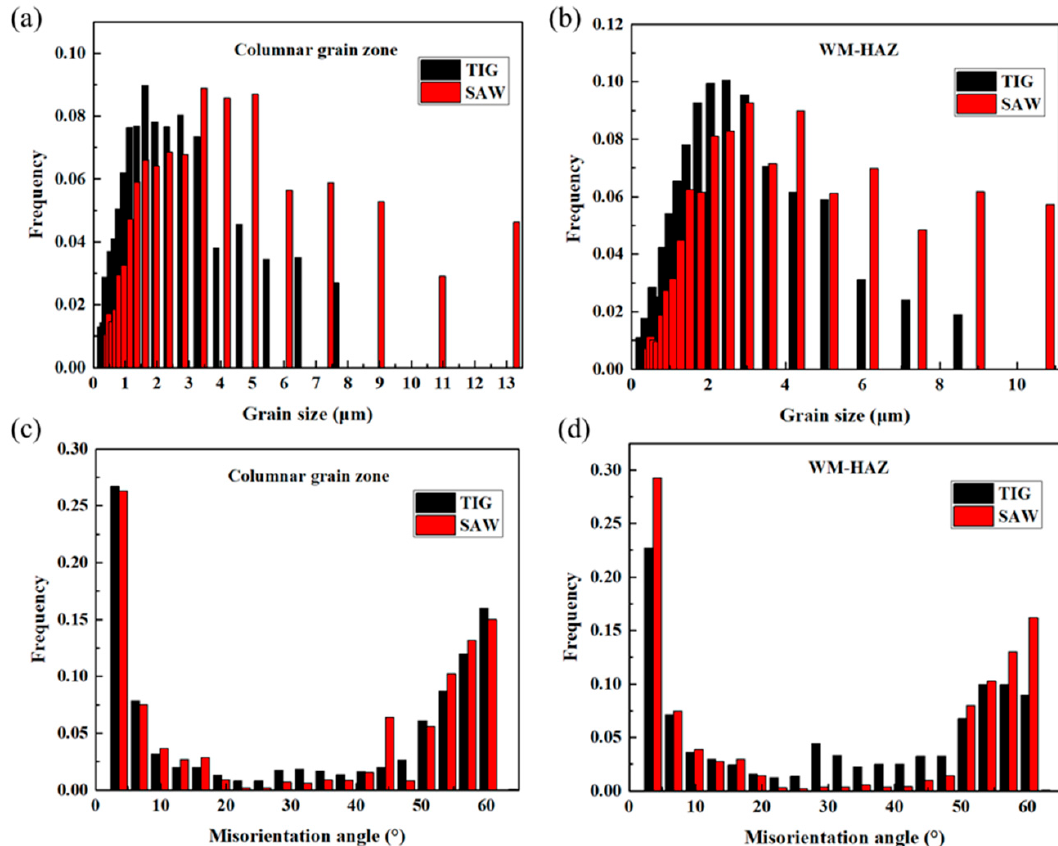
Figure 7. The distributions of grain size and number fraction of misorientation angles in columnar grain and reheated zones of weld metal. ( a ) The distribution of grain size of columnar grain zone in TIG and SAW weld; ( b ) The distribution of grain size of WM-HAZ in TIG and SAW weld; ( c ) The distribution of misorientation angles of columnar grain zone in TIG and SAW weld; ( d ) The distribution of misorientation angles of WM-HAZ in TIG and SAW weld.